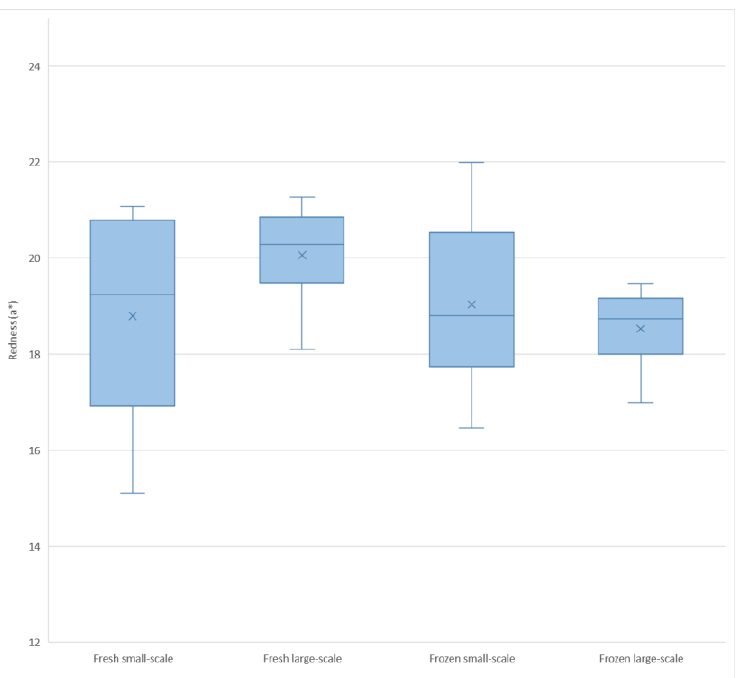
Figure 1. Boxplot showing redness (a*) for fresh and frozen meat samples from the small-scale and large-scale abattoirs.